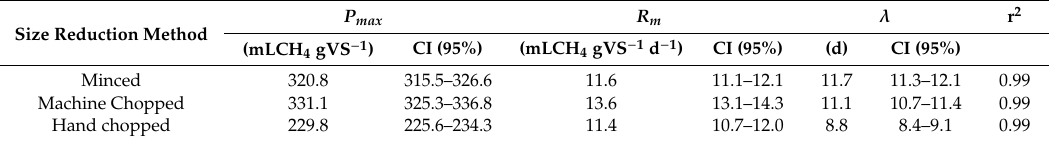
Table 4. Parameters of the Gompertz equation fits on the BMP tests data according the size reduction method ( Pm , Rm and λ ), confidence interval (CI with α = 0,05) and evaluation of the coefficient of determination (r 2 ).